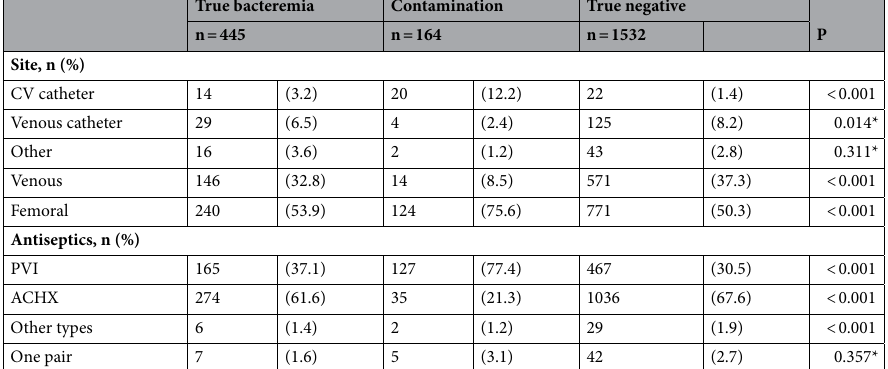
Table 2. Characteristics of blood cultures. ACHX, 1.0% alcohol/chlorhexidine gluconate; CV, central venous; Femoral, femoral artery or vein; Other types, alcohol and benzalkonium; Other, recently inserted arterial catheter and implanted port; PVI, 10% aqueous povidone-iodine; Venous, venipuncture without catheter insertion; Venous catheter, recently inserted venous catheter. *Fisher exact test was performed because of small number of patients in several cells; other groups were analyzed by two-tailed χ 2 test.